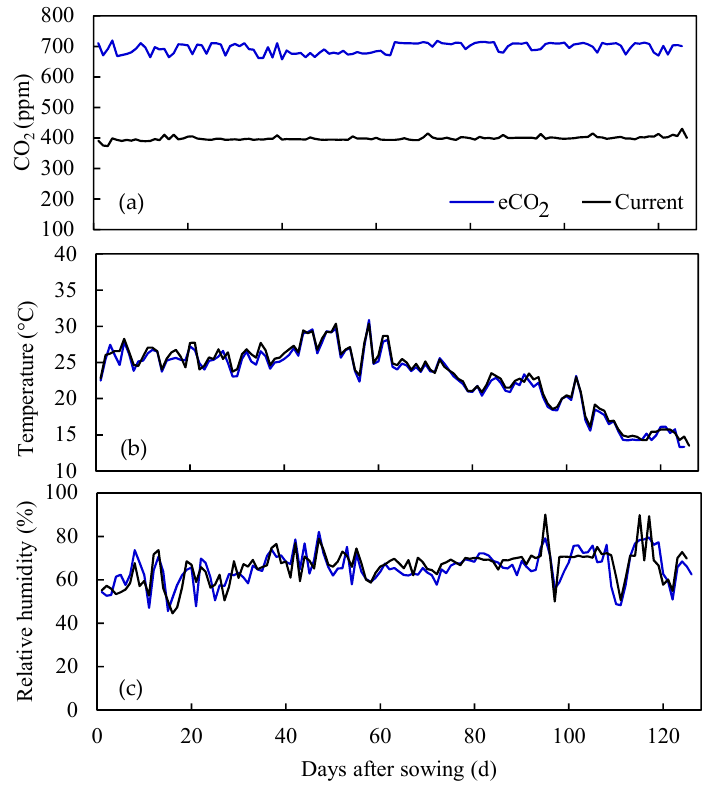
Figure 2. Daily variations in ( a ) carbon dioxide (CO 2 ) concentrations; ( b ) temperature and ( c ) relative humidity under current and elevated CO 2 (eCO 2 ) treatments. Table 1. The growth stages and application of irrigation and fertilizer for maize under current and elevated CO 2 (eCO 2 )